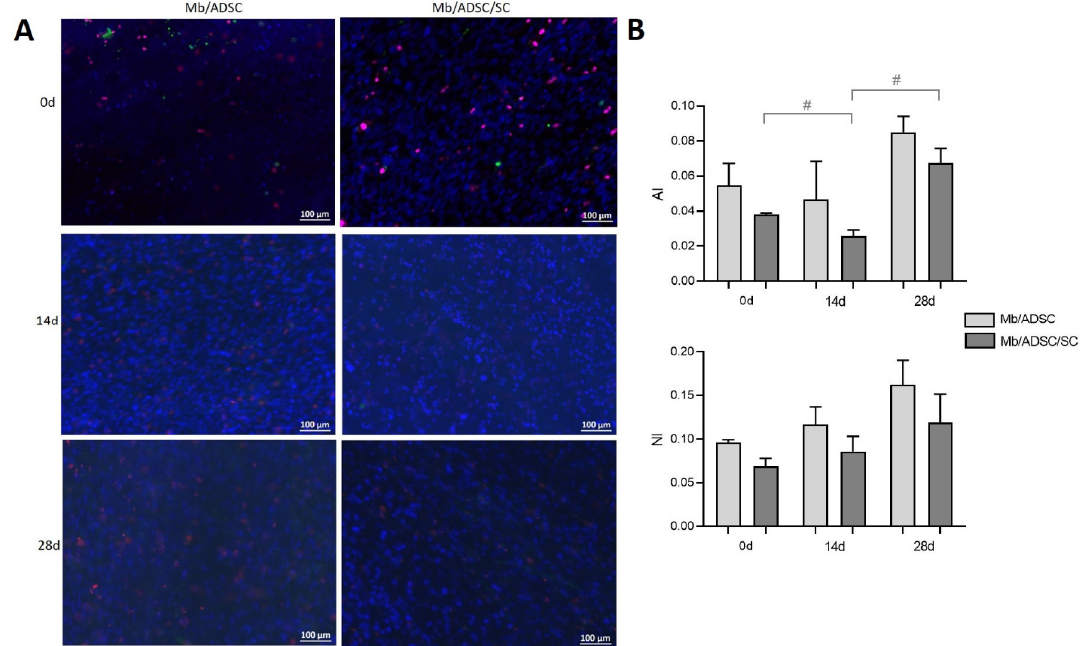
Figure 8. Cell status on PCL-collagen I-nanofibers determined with live dead assay. ( A ) After 0, 14, and 28 days of myogenic differentiation, live cells are demonstrated in blue, apoptotic cells in green, and necrotic cells in red. Scale bar 100 µm. ( B ) Apoptotic index (AI) and necrotic index (NI) did not differ between Mb/ADSC and Mb/ADSC/SC (unpaired t-test). AI decreased from 0 days to 14 days (# p < 0.05, repeated measures ANOVA with Tukey’s correction for multiple comparisons) and increased from 14 days to 28 days (# p < 0.05, repeated measures ANOVA with Tukey’s correction for multiple comparisons) for Mb/ADSC/SC.